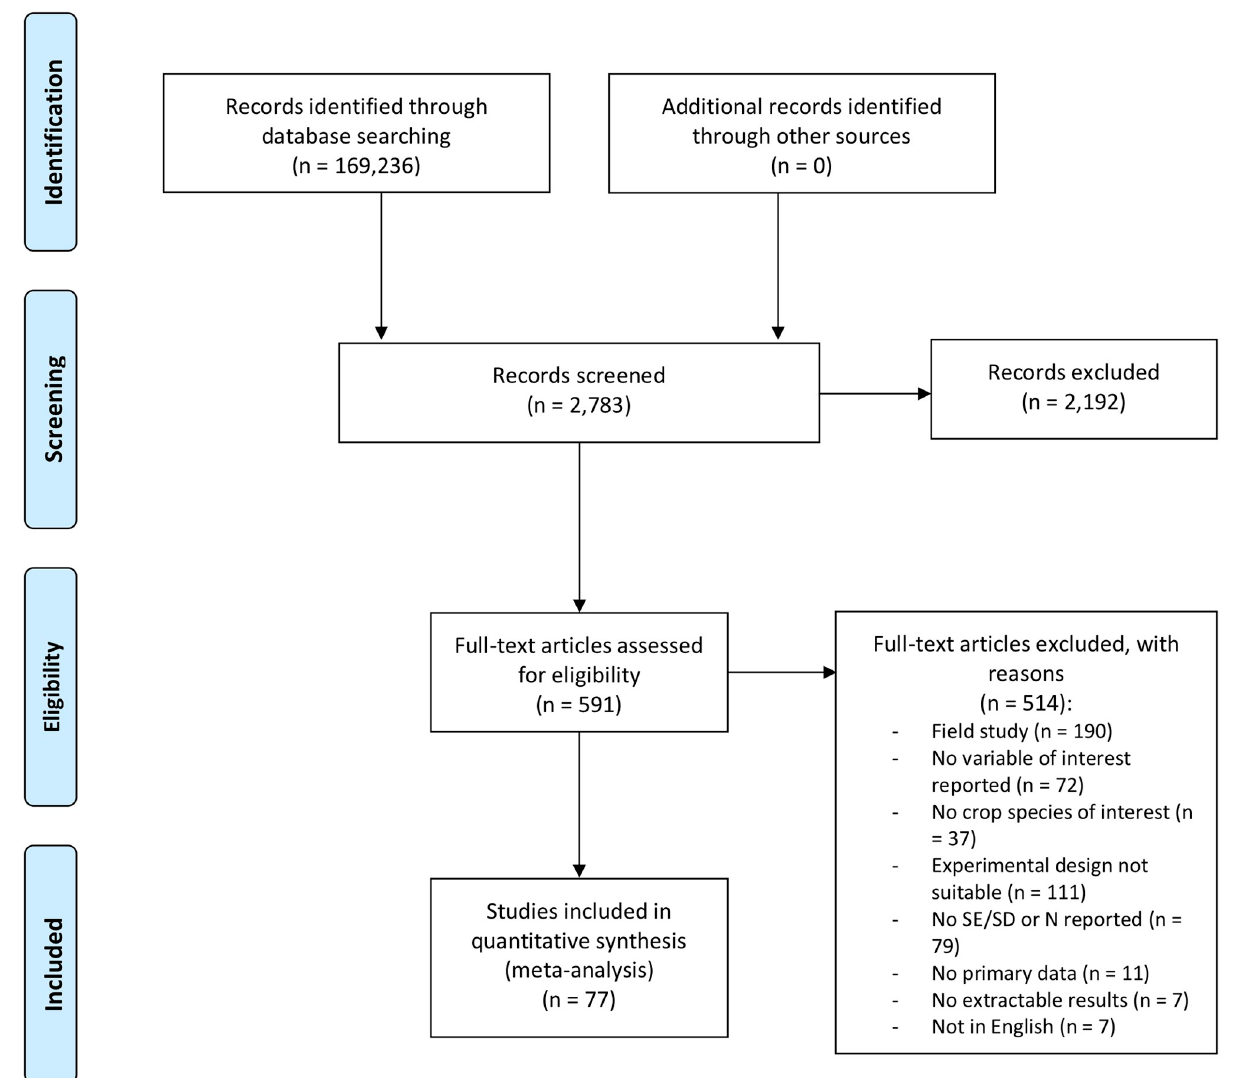
Fig 1. PRISMA flow diagram of database searching and article screening. The complete PRISMA checklist can be found in S2